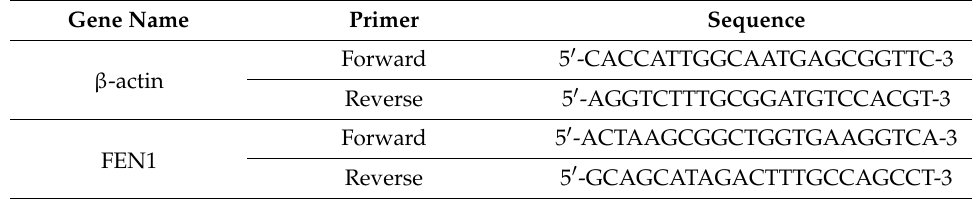
Table 1. Primers for qPCR